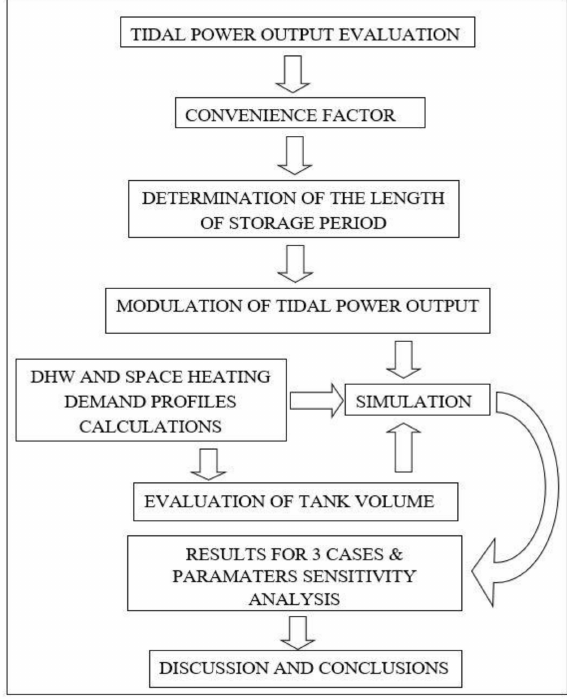
Figure 1. Logical approach followed for conducting the feasibility